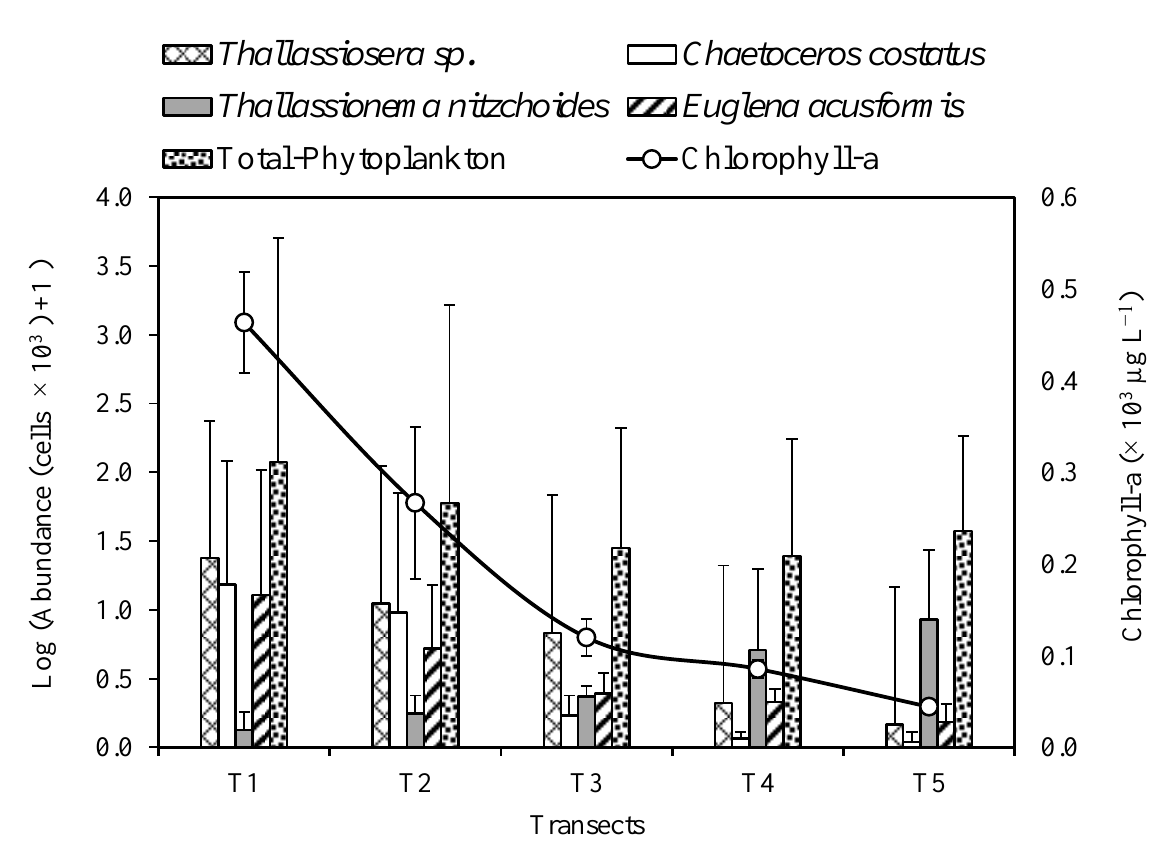
Figure 7. Spatial abundance of most important phytoplankton taxa, total phytoplankton, and Chlorophyll-a along the five transects. Table 3. Species composition of Copepoda collected in 15 stations in the Gulf of Gab è s. Taxa with an heterogeneous composition (e.g. nauplii, copepodids, adults) are not